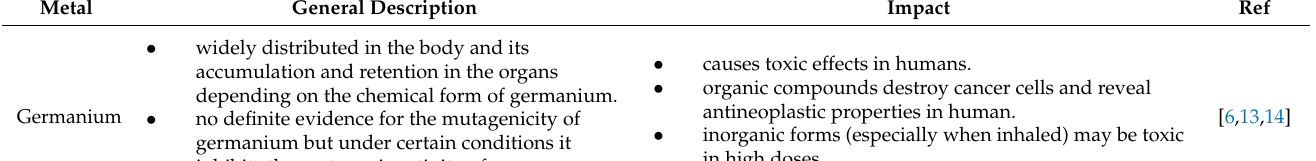
Table 1. Characteristics of TCE metals with the influence of these metals on living organisms. General Description